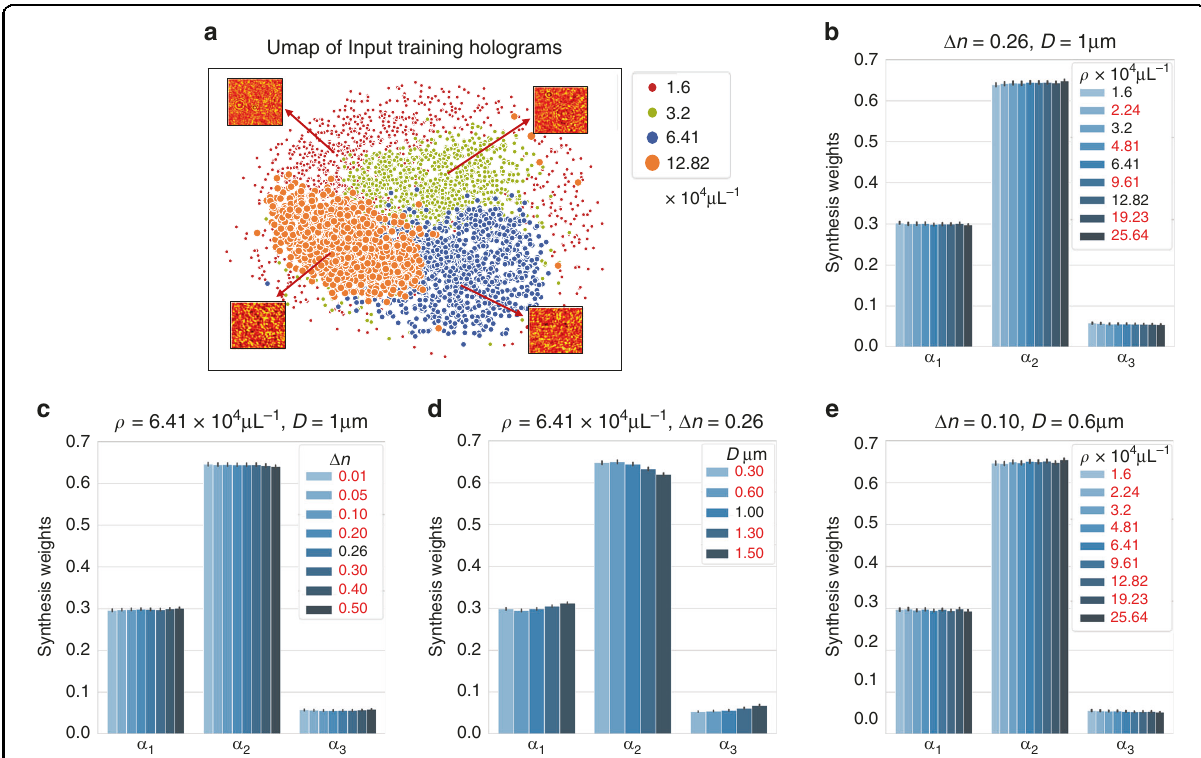
Fig. 6 Gating network analysis. a The 2D UMAP representation for the measured hologram patches used in the training. Hologram patches with similar particle densities cluster together, indicating their statistical similarity. Thus, the hologram can serve as a proxy to the scattering level and is used as the input to the GTN to predict the synthesis weight. The synthesis weights are shown for various seen (legend in black) and unseen (legend in red) scattering conditions, including b different particle densities, c different refractive indices, d different particle diameters, and e different particle densities with an unseen particle refractive index and size. The synthesis weights are consistent for each condition and further tailored to each input, as quanti fi ed by the mean and standard deviation for each case. The larger values of α 2 indicate the major contributions of F 2 and D 2 to the DSN. As the particle density increases, α 2 increases while α 1 and α 3 decrease regardless of whether the particle size and refractive index are seen ( b ) or unseen ( e